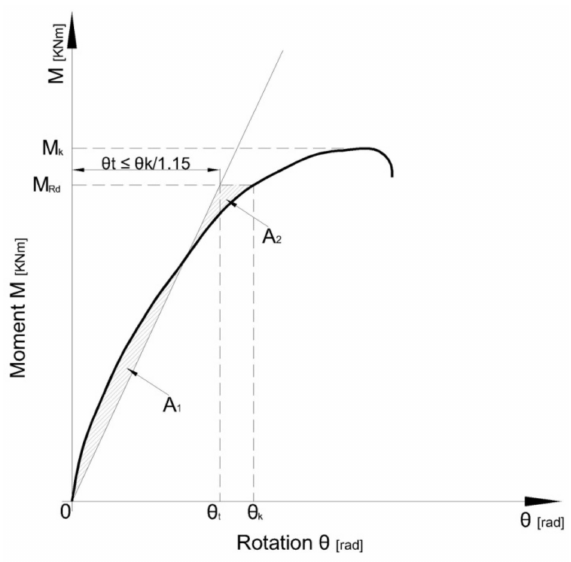
Figure 7. Computing of the rotational sti ff ness k ni , according to EN15512 [9]. The standard deviation of the adjusted test results denoted with s is computed with Equation (10), according to EN 15512